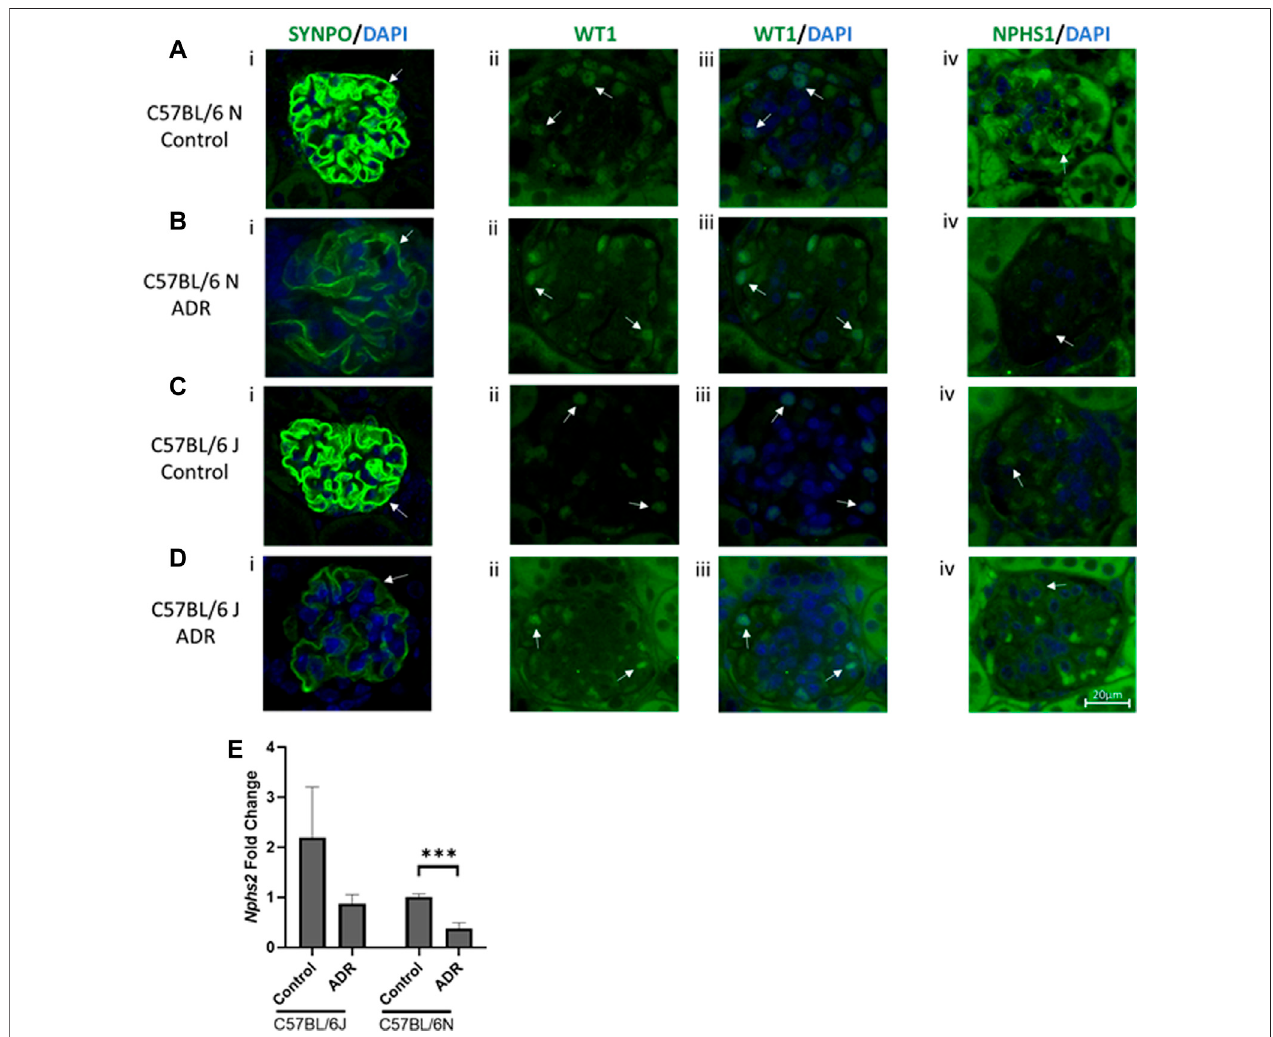
FIGURE3| AlbuminuriaisAssociated withPodocyteInjury inNand JSubstrainswithAdriamycin-Induced Nephropathy. (A – D) Immuno fl uorescence stainingand evaluation of glomeruli and podocytes with synaptopodin, WT1 and nephrin (scale bar = 20 μ m). Representative images showing glomerular and podocyte (i) SYNPO (green)/DAPI(blue), (ii) WT1(green), (iii) WT1(green)/DAPI(blue),and (iv) NPHS1(green)/DAPI(blue)stainingfrom (A,B) C57BL/6NcontrolandADR-injectedmice,and (C,D) , C57BL/6 J control and ADR-injected mice. (ii, iii) WT1 colocalization with DAPI in the nucleus is indicated by a light blue color. Podocyte and glomerular speci fi cstainingisindicatedwitharrows.Atleastthreeglomerulifromthreemicepergroupwereexamined. (E) RNAwasisolatedfromthekidneycortexfromC57BL/6 J and Nsubstrains,control and ADR-injected mice. Nphs2 /Podocin expression foldchangeisshown comparing controland ADR-treated mice.*** p < 0.001 byunpaired student t -test, n =